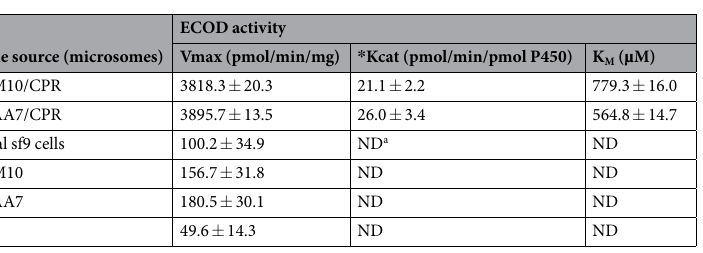
Table 1. ECOD activity of P450/CPR microsomal proteins. * Kcat is the turnover number, calculated as Vmax/ [E concentration]. ND a : Not